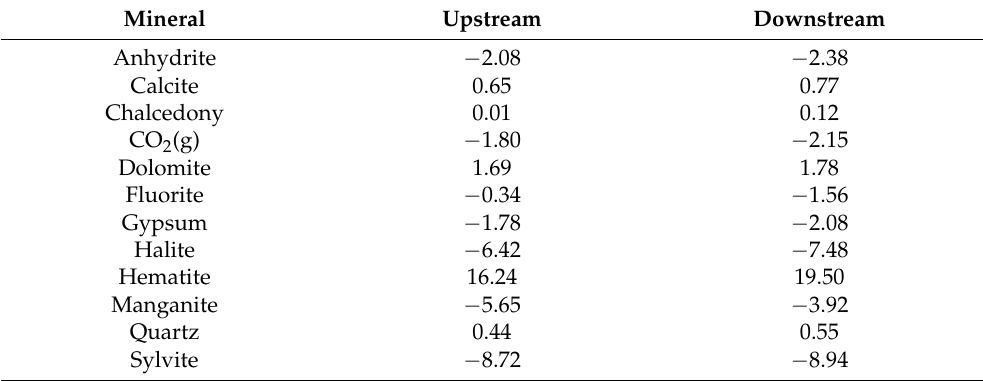
Table 4. Upstream and downstream water saturation indices along the reaction path.